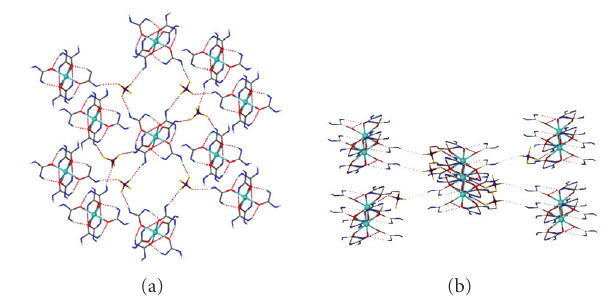
Figure 7: Views of the 3D framework formed by hydrogen bonds between the [Co(DEU) 6 ] 2+ cations and the BF 4 − anions in 1 .